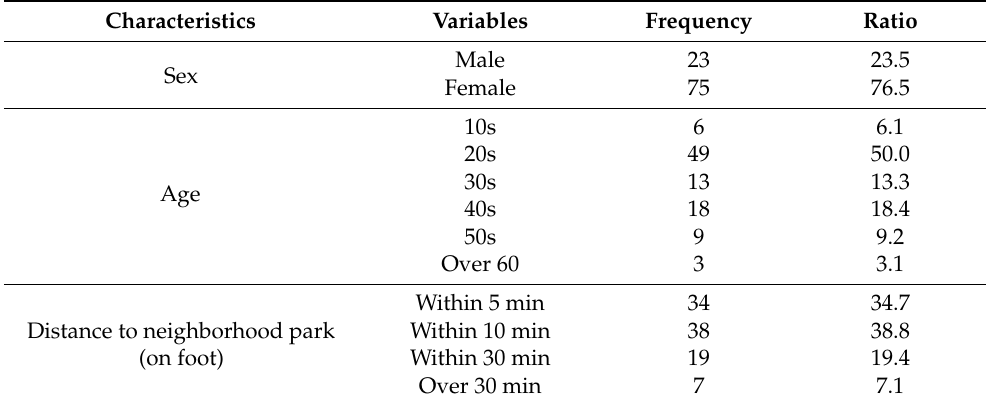
Table 4. General characteristics of